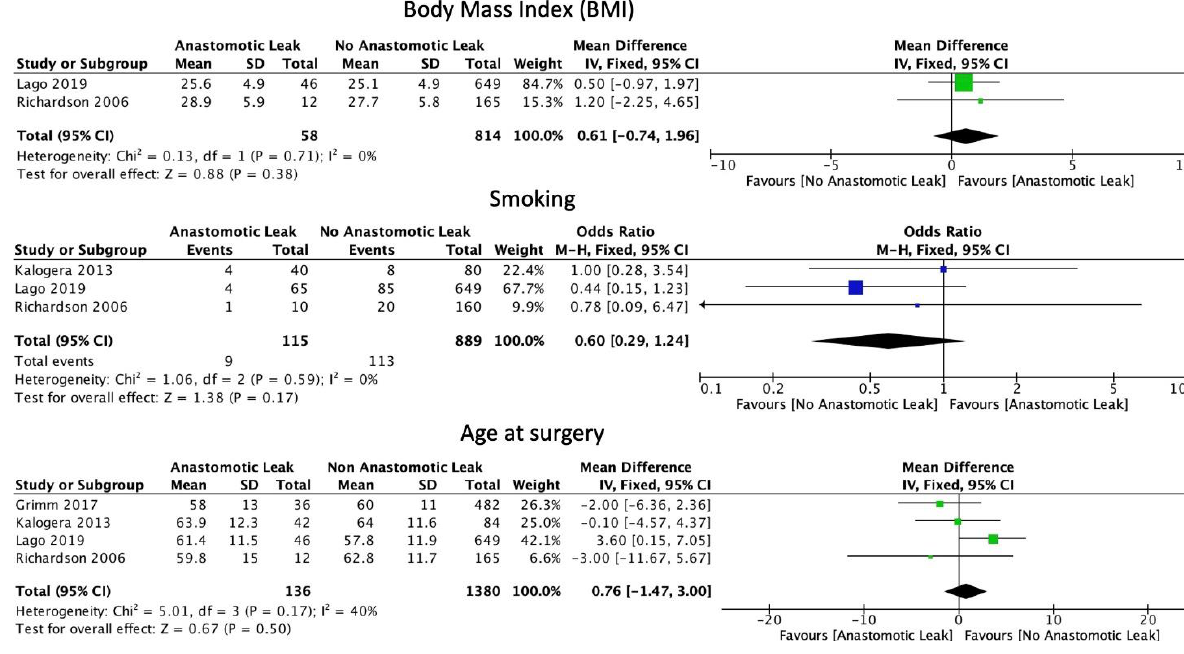
Figure 2. Basic patient characteristics.